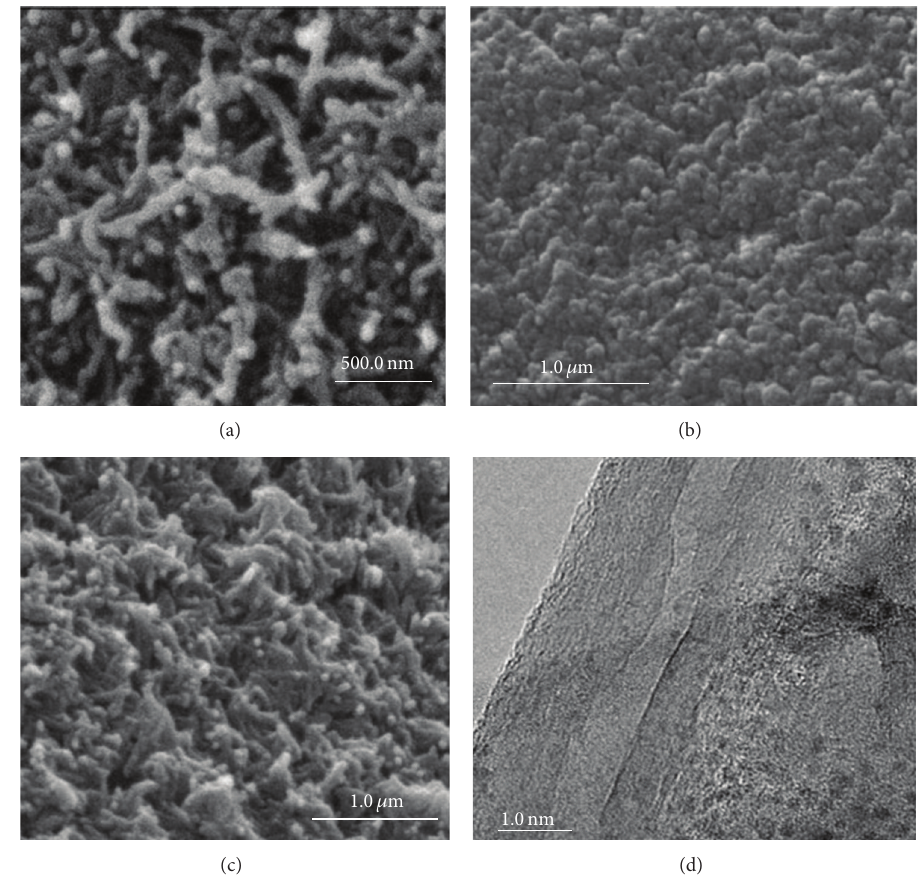
Figure 2: SEM micrographs of (a) MWNTs, (b) the CS/HA composite, (c) the CS-MWNTs/HA composite, and (d) TEM micrographs of the CS-MWNTs/HA composites [36].